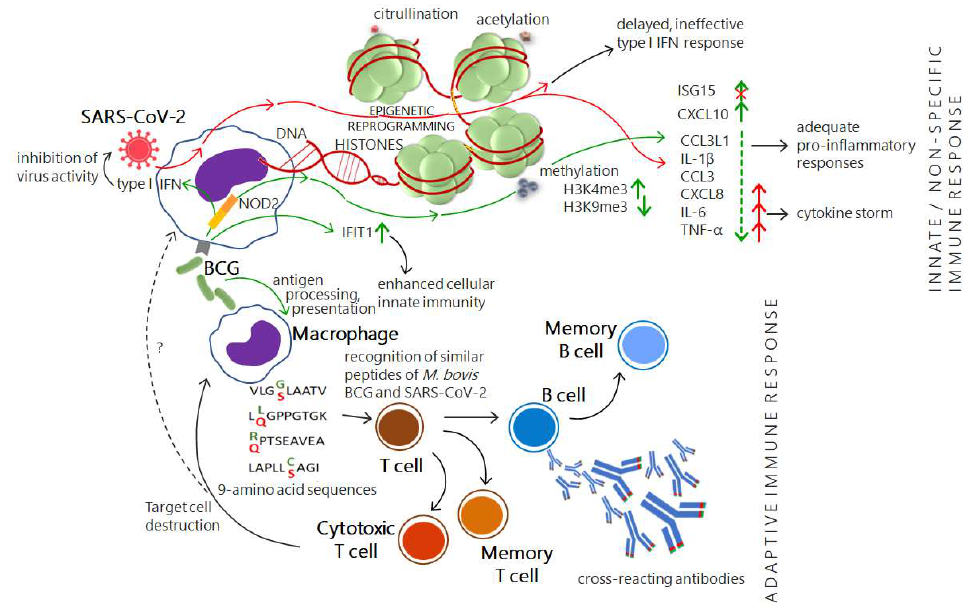
Figure 1. Possible BCG vaccine cross-reaction with SARS-CoV-2 and its mechanism of action. The effectiveness of the immune response consists in the balanced reactivity of both innate and adaptive immunity and their cooperation. It has been shown that cells of innate immunity (for example, macrophages) undergo a process of immune training underpinned by epigenetic changes. BCG, through the induction of epigenetic reprogramming (manifested, for instance, by the production of pro-inflammatory cytokines at appropriate levels), can provide cross-protection during a subsequent infection caused by an infectious agent other than the primary one. Genes, particularly interferon- related, are also subject to epigenetic control by the SARS-CoV-2 virus, the infection of which may be accompanied by the increased production of pro-inflammatory cytokines leading to a cytokine storm. The interferon pathway is one of the most important signaling pathways in the course of infection. In viral infection, an increase in the levels of ISGs is observed, whose stimulation results in the inhibition of viral replication. The BCG vaccine, in particular, leads to the upregulation of ISG15, which may confirm its contribution to the inhibition of viral infection. However, in the case of SARS-CoV-2, its ability to alleviate some ISG15 anti-viral activities was reported. Among the components of the interferon pathway are IFIT proteins. The antiviral properties of IFIT1 are manifested by the recognition of RNA having 5′ triphosphate and lacking 2′-O methylation, followed by the sequestration of the viral nucleic acid. The elevated IFIT1 levels observed after BCG vaccination may indicate its usefulness in mitigating the SARS-CoV-2 infection. Furthermore, it was reported that M. bovis BCG contains similar T cells epitops asSARS-CoV-2. The consequence of this can be the production of cross-reactive antibodies by antigen-specific B lymphocytes. Hence, it has been suggested that BCG immunization, as well as latent M. tuberculosis infection, may result in an increased effectiveness of the immune system against SARS-CoV-2, not only due to the training of innate immunity but also through the generation of antibodies with cross-reactivity. Abbreviations: CCL3—